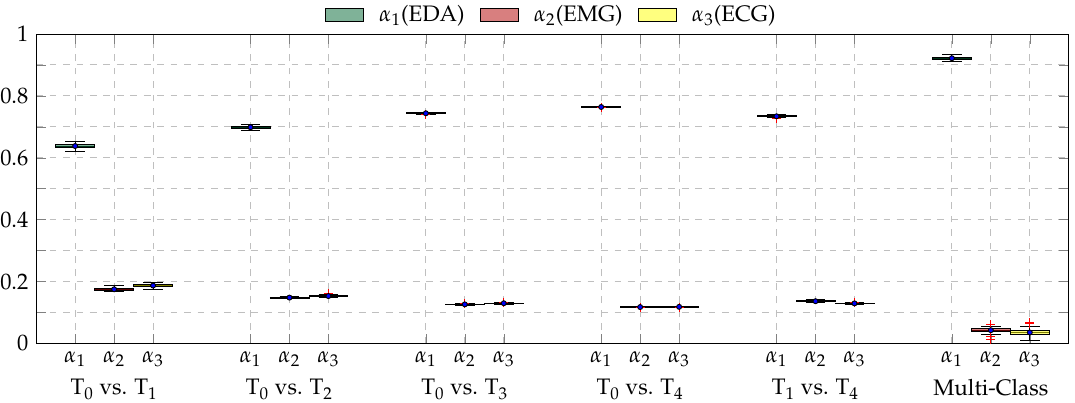
Figure 5. Box plots of the weighting parameters α 1 , α 2 and α 3 for the late fusion architecture (Late Fusion (b)), computed during the LOSO cross-validation evaluation of each conducted classification experiment. Within each box plot, the mean and median values of the performed LOSO cross-validation evaluation are depicted with a dot and a horizontal line,